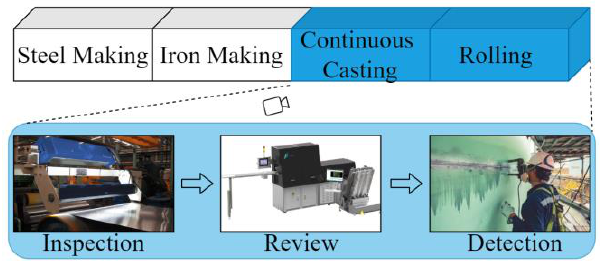
Figure 2. Steel manufacturing process and defect detection steps [6].